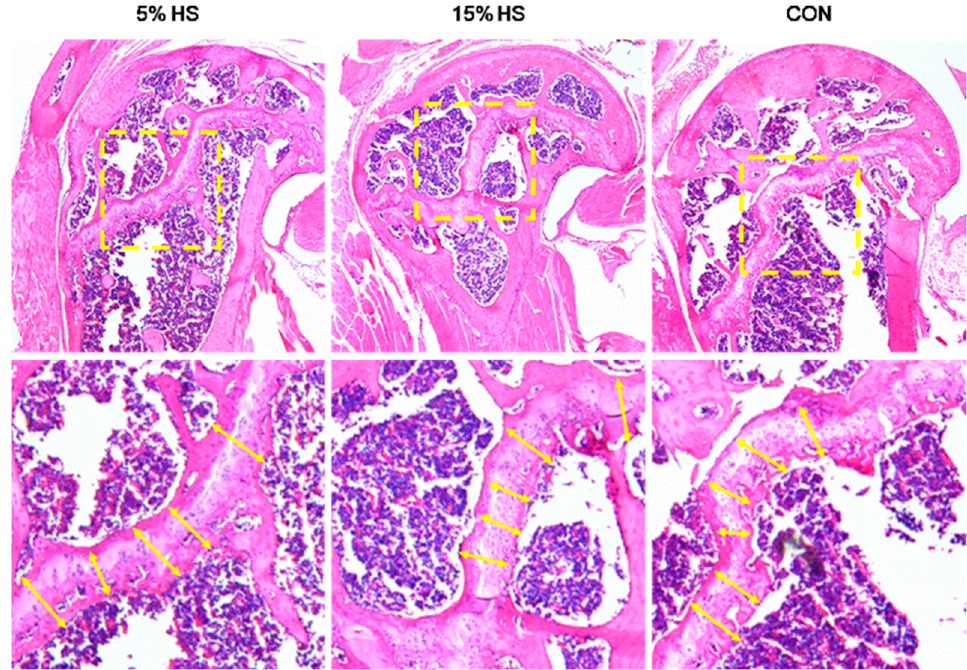
Figure 1. H&E-stained sections of the humerus distal epiphyseal plate from mice representing the three treatment groups (5% HS, 15% HS and control). Top row: Yellow dashed line boxes show the region of interest. Bottom row: Yellow arrows indicate the positioning of markers of measurements of growth plate thickness. For each image, only 5–6 markers (of 20 total per sample) are shown to better visualize the growth plate.